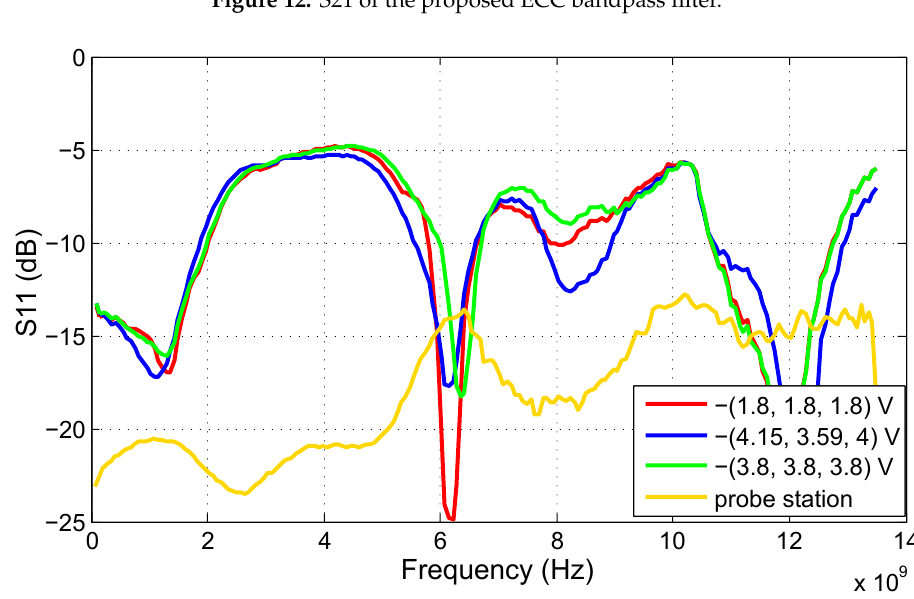
Figure 12. S21 of the proposed ECC bandpass filter.